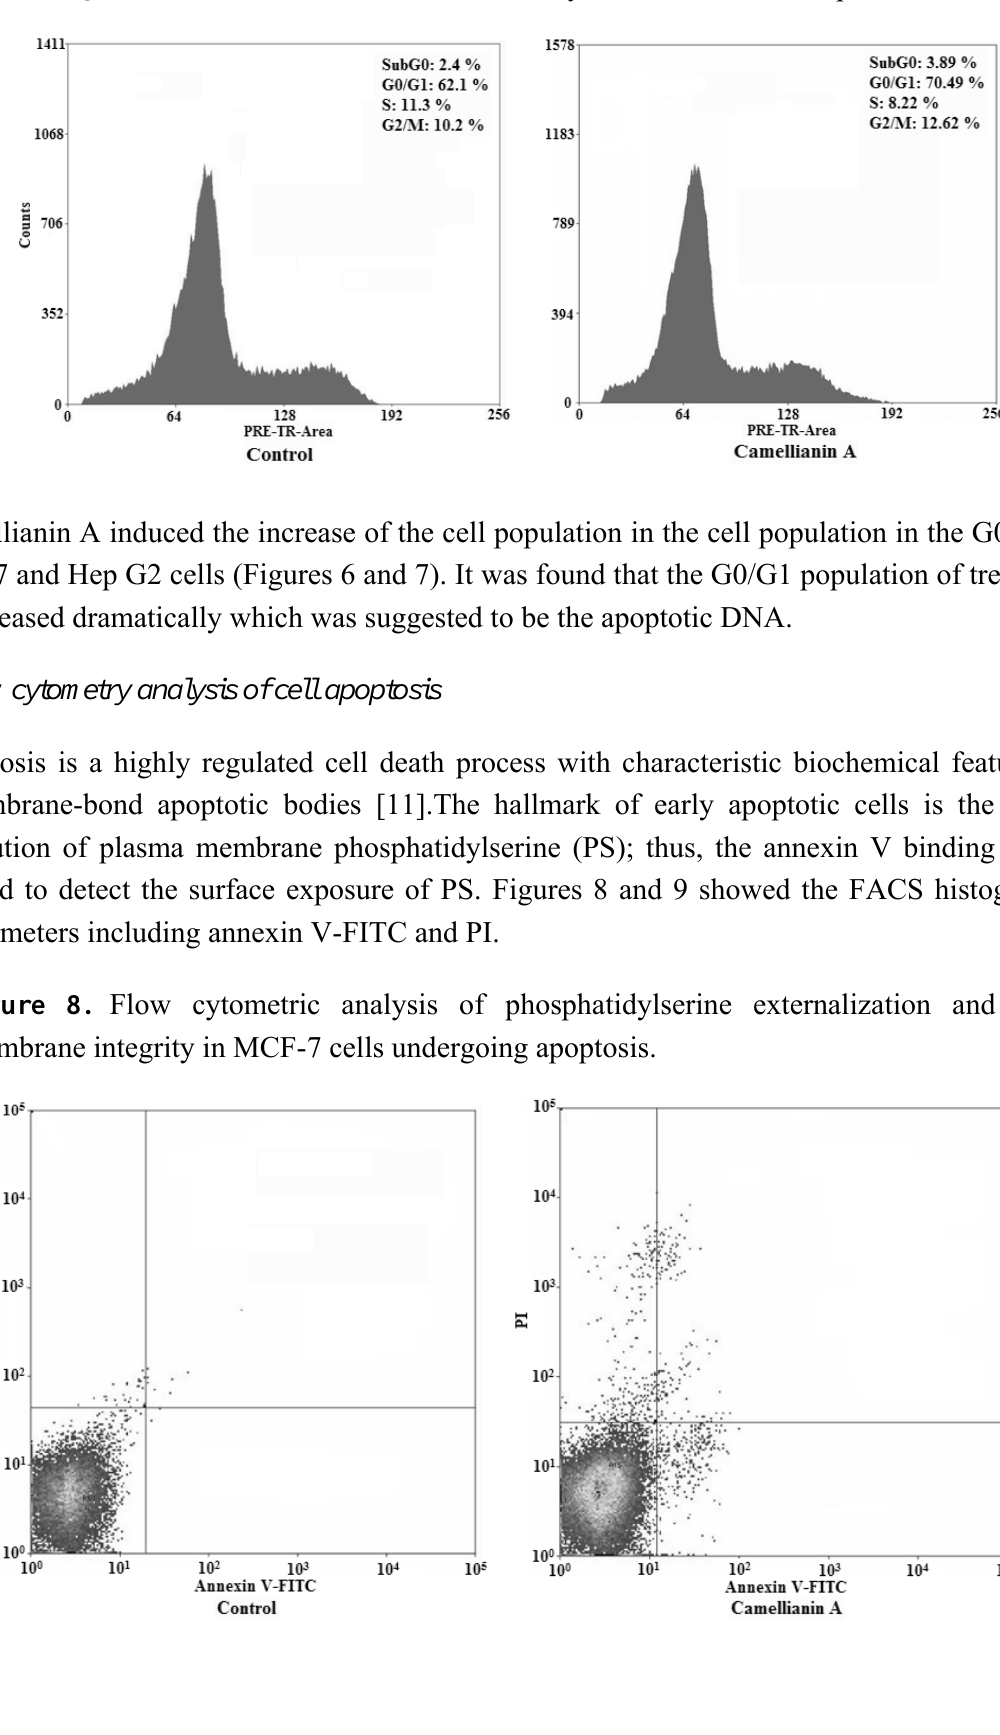
Figure 7. Effect of camellianin A on cell cycle distribution in Hep G2 cells.